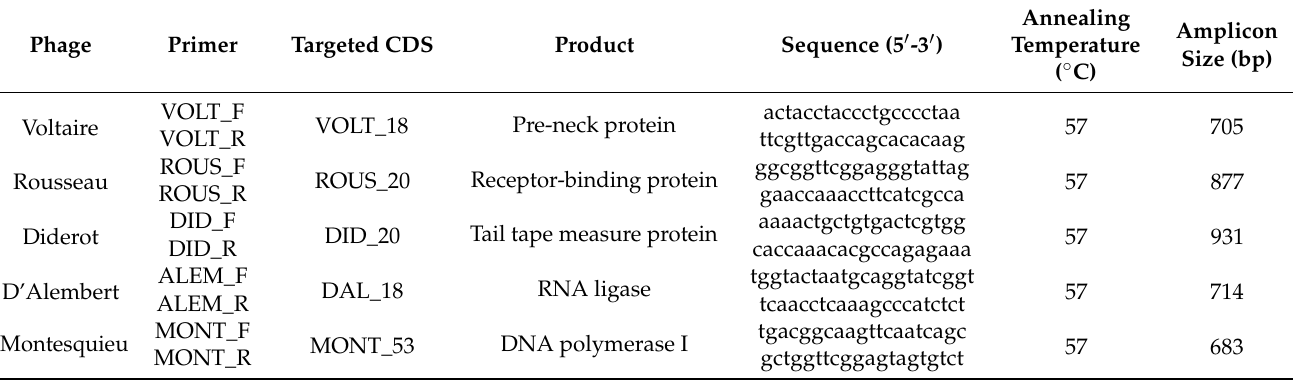
Table 2. PCR primers targeting specific phage